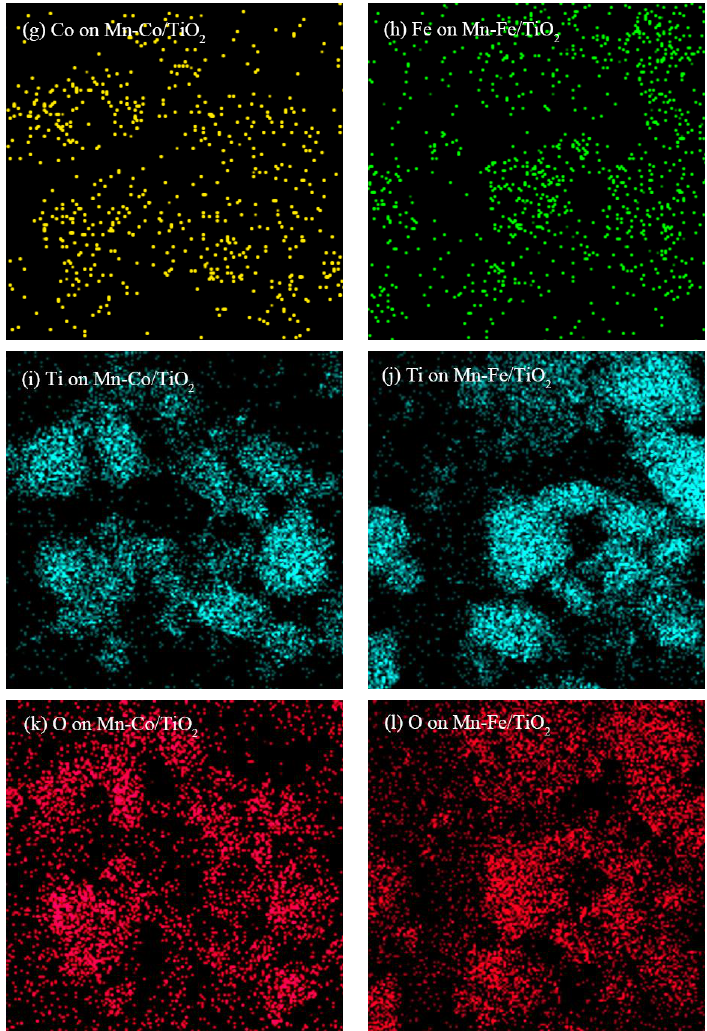
Figure 1. TEM, SEM, and Mapping of Mn−Co/TiO 2 and Mn−Co/TiO 2 nanocatalysts. ( a ) TEM of Mn−Co/TiO 2 ; ( b ) TEM of Mn−Fe/TiO 2 ; ( c ) SEM of Mn−Co/TiO 2 ; ( d ) SEM of Mn−Fe/TiO 2 ; ( e ) Mapping of Mn on Mn−Co/TiO 2 ; ( f ) Mapping of Mn on Mn−Fe/TiO 2 ; ( g ) Mapping of Co on Mn−Co/TiO 2 ; ( h ) Mapping of Fe on Mn−Fe/TiO 2 ; ( i ) Mapping of Ti on Mn−Co/TiO 2 ; ( j ) Mapping of Ti on Mn−Fe/TiO 2 ; ( k ) Mapping of O on Mn−Co/TiO 2 ; ( l ) Mapping of O on Mn−Fe/TiO 2 .